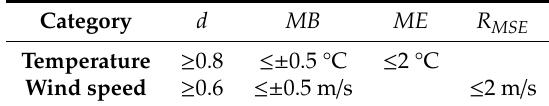
Table 1. Statistical benchmarks for the wind speed and temperature.